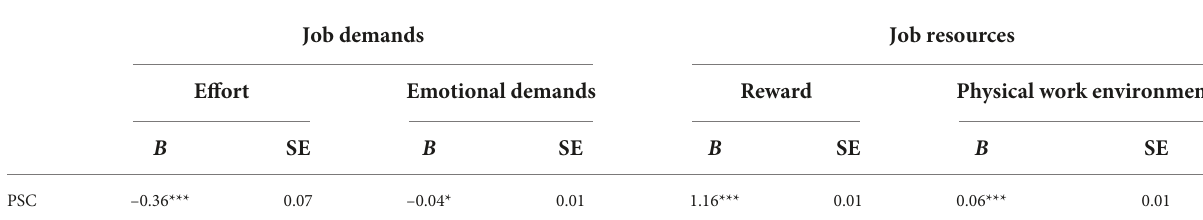
TABLE 4 Multilevel random coefficient model (adjusted for age and gender) examining the relationship between PSC and Job Demands/Resources (H1).